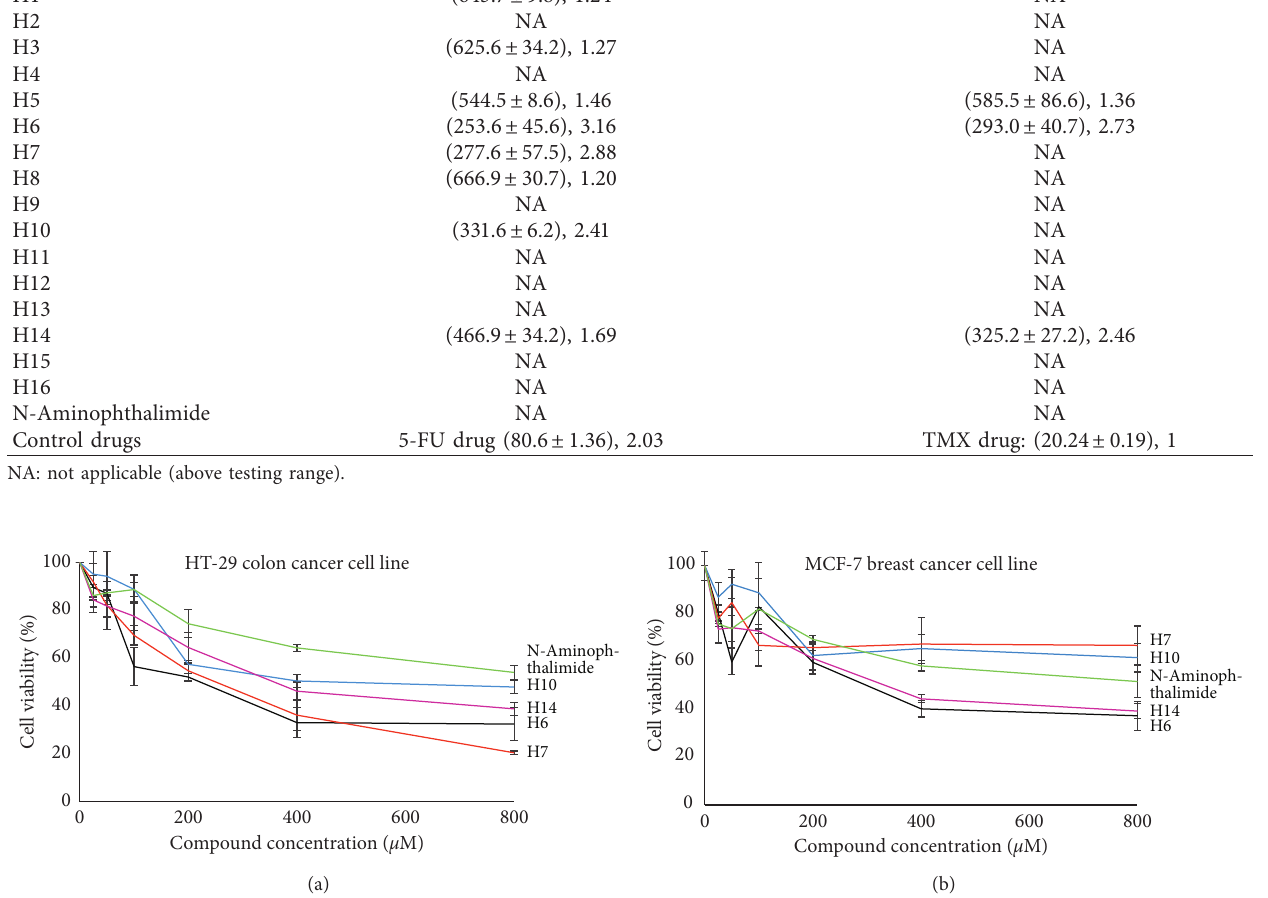
Table 3: IC 50 values and selectivity indices (SI) of cancer cells treated with imines compounds. Sample